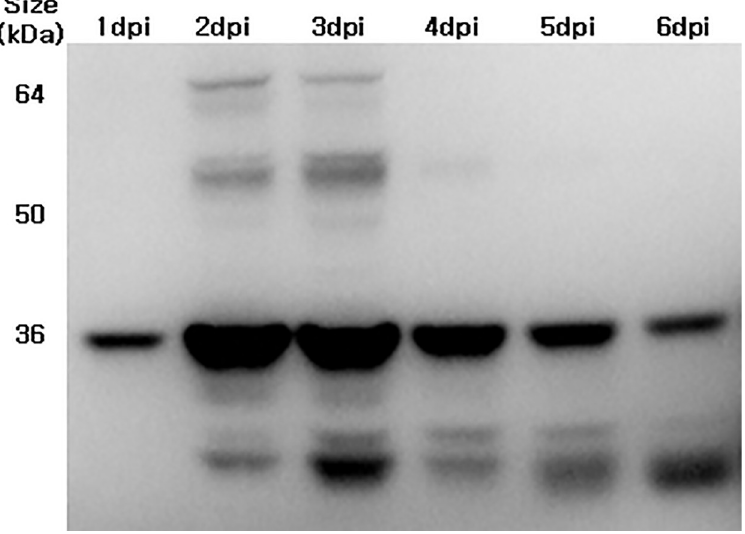
Fig 2. Western blot analysis of Hi-5 cell lysates infected with Baculo-P1-3CD-gp41 at MOI 5 during different times. Hi-5 cell lysate protein was analyzed using an anti-VP2 MAb (MAb979). The cells were harvested from 1–6 dpi.